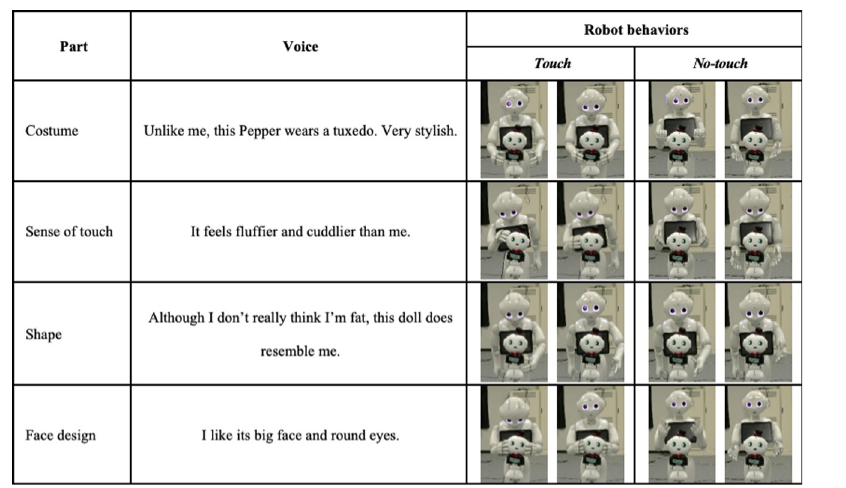
Fig 3. Speech contents and robot behaviors in each